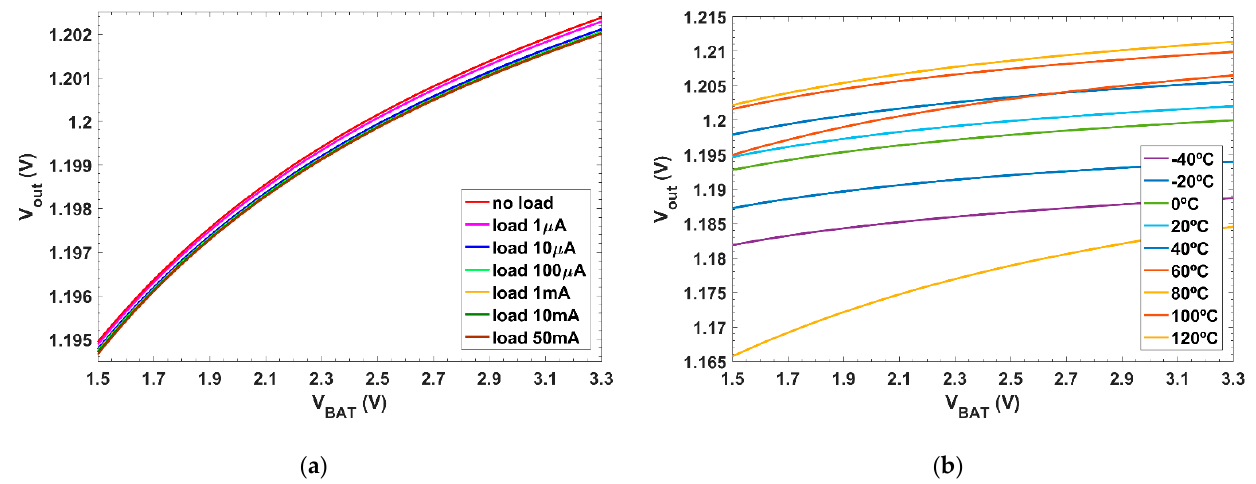
Figure 12. Quiescent current, I q , at: ( a ) room temperature, T room ; and ( b ) different temperatures.